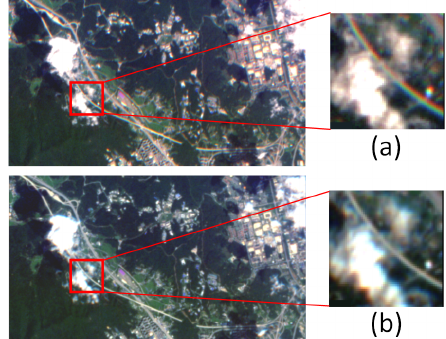
Figure 1. Influence of moving clouds on multi/hyperspectral band registration in the cloudy image. (a) Registration results of band red, green and blue using the vision-based method. Roads become rainbow-like due to the movement of clouds. (b) Results after eliminating cloud motion with our